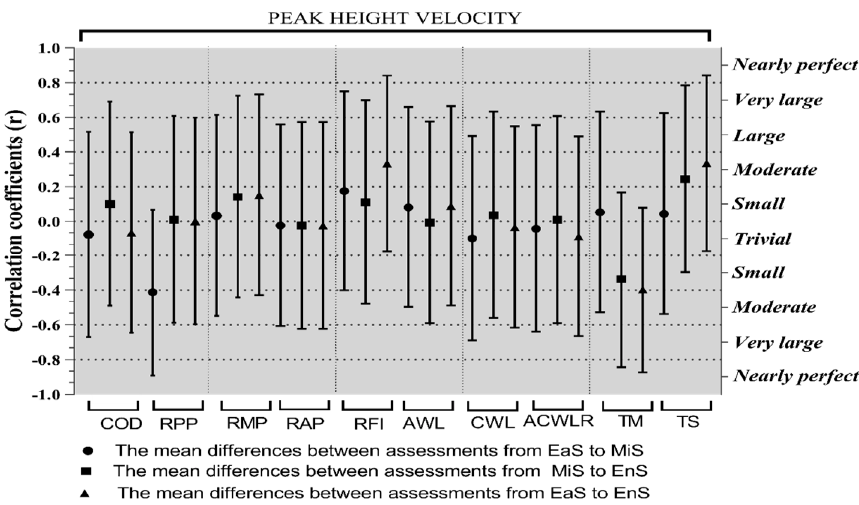
Figure 2. Correlation coefficients (at level of 95% confidence interval) for the peak height velocity soccer player. COD (seconds) = change of direction; RPP (watts) = Running-Based Anaerobic Sprint Test (RAST) of peak power; RMP (watts) = RAST of minimum power; RAP (watts) = RAST of average power; RFI = RAST of fatigue index; AWL(A.U.) = acute workload; CWL (A.U.) = chronic workload; ACWLR (A.U.) = acute: chronic workload ration; TM (A.U.) = training monotony; TS (A.U.) = training strain; and A.U. = Arbitrary unit.